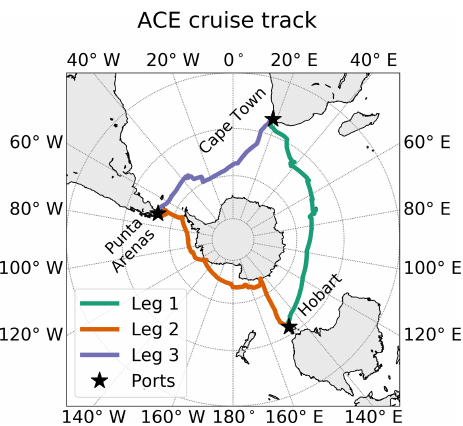
Figure 1. Hourly position of the RV Akademik Tryoshnikov during ACE. The ports visited as part of the cruise are indicated (stars). Leg 1 (green) from Cape Town (South Africa) to Hobart (Aus- tralia) between 20 December 2016 and 19 January 2017, Leg 2 (or- ange) from Hobart to Punta Arenas (Chile) between 22 January and 22 February 2017, and Leg 3 (purple) from Punta Arenas to Cape Town between 26 February and 19 March